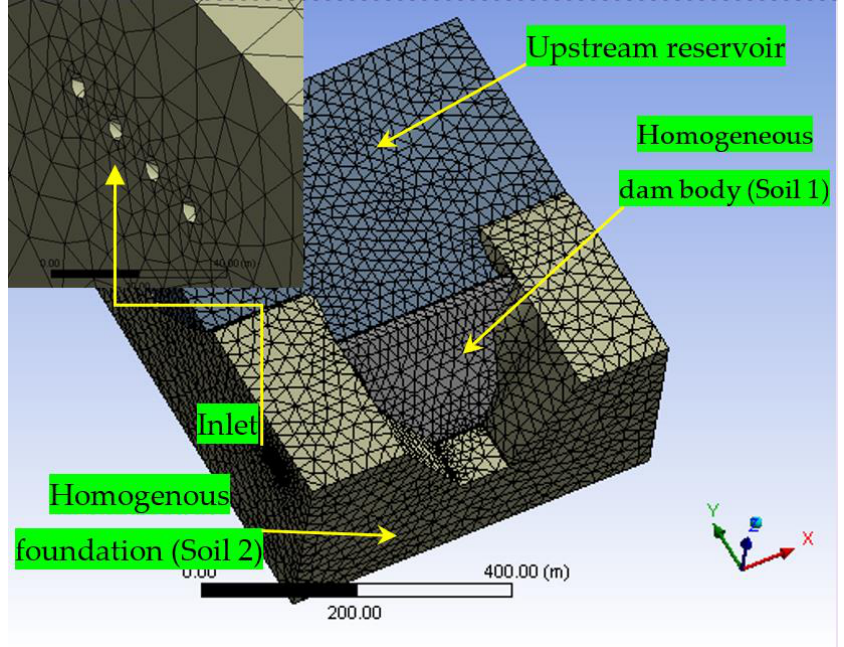
Figure 7. 3D Finite element model of the Temenggor dam rock-bed and full reservoir.